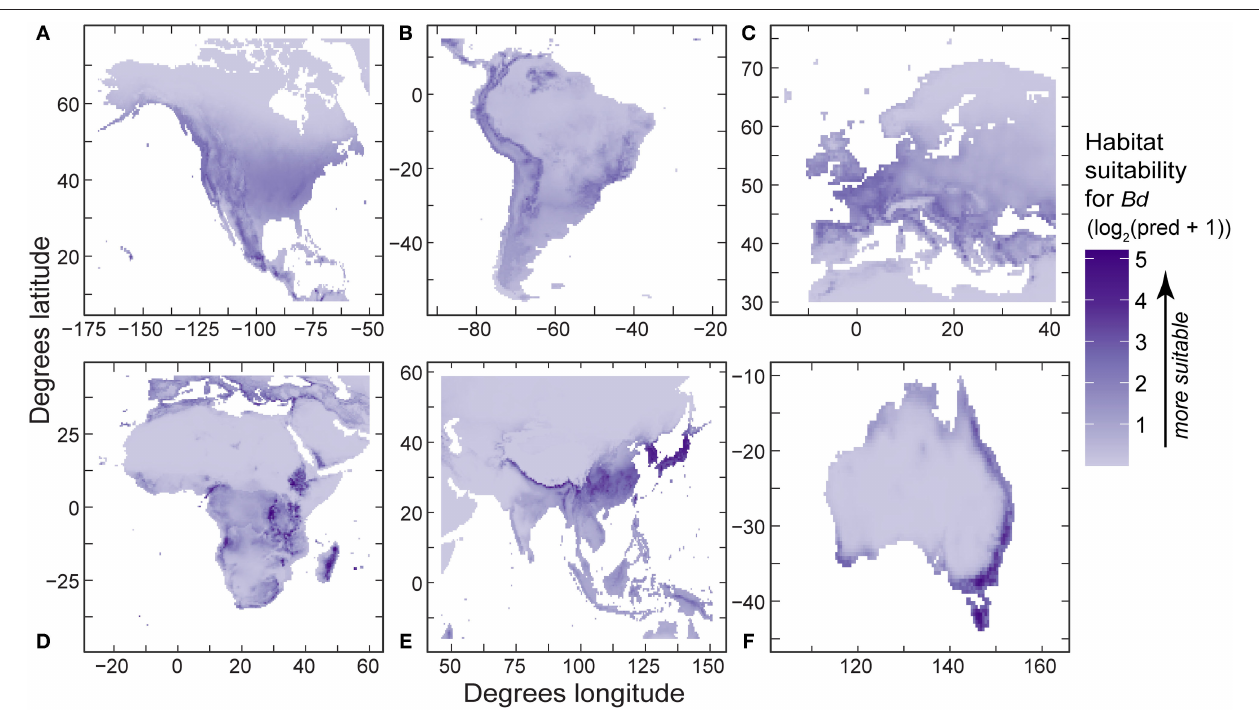
FIGURE 7 | Regional predictions of Batrachochytrium dendrobatidis ( Bd ) habitat suitability from our best-fit presence-only species distribution models (log 2 -transformed [log base 2] probability ration output, area under curve values in Table 5 ) using Bd data compiled through December 2019 for: (A) North America; (B) South America; (C) Europe; (D) Africa; (E) eastern Asia; and (F)